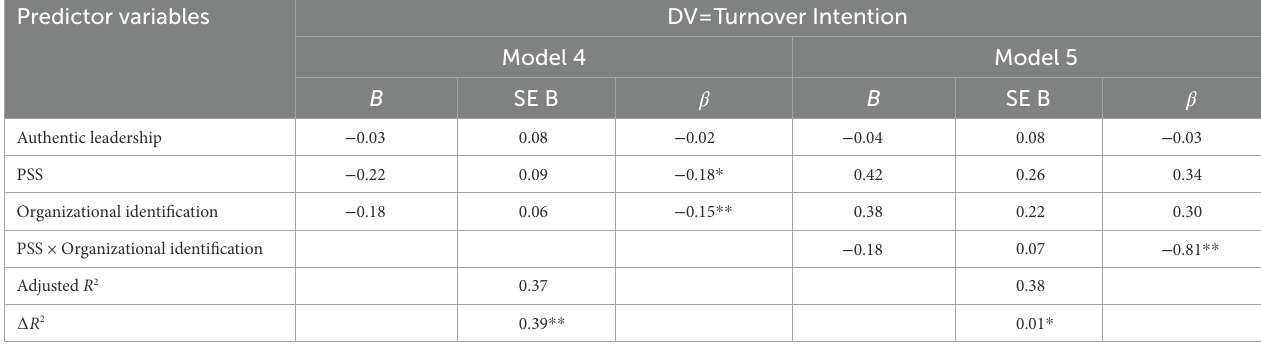
TABLE 4 Regression analyzes for Hypothesis 3. Predictor